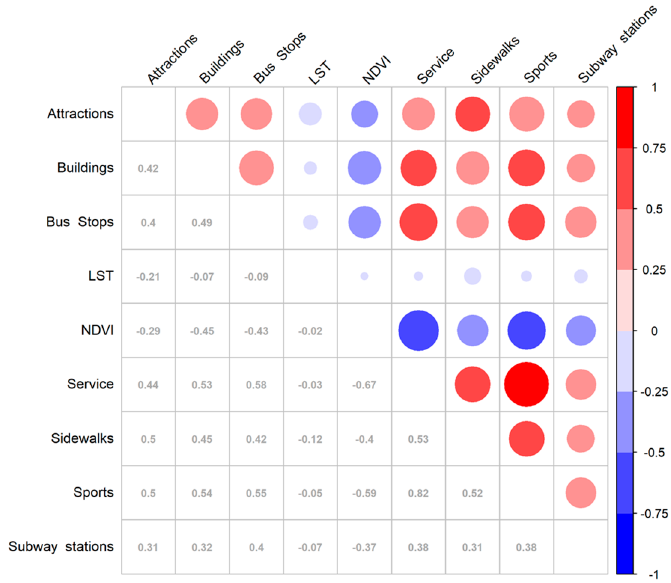
Figure 4. Correlation matrix of 9 environmental variables.